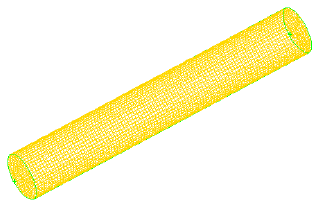
Figure 5. Mesh model in the CFD software.